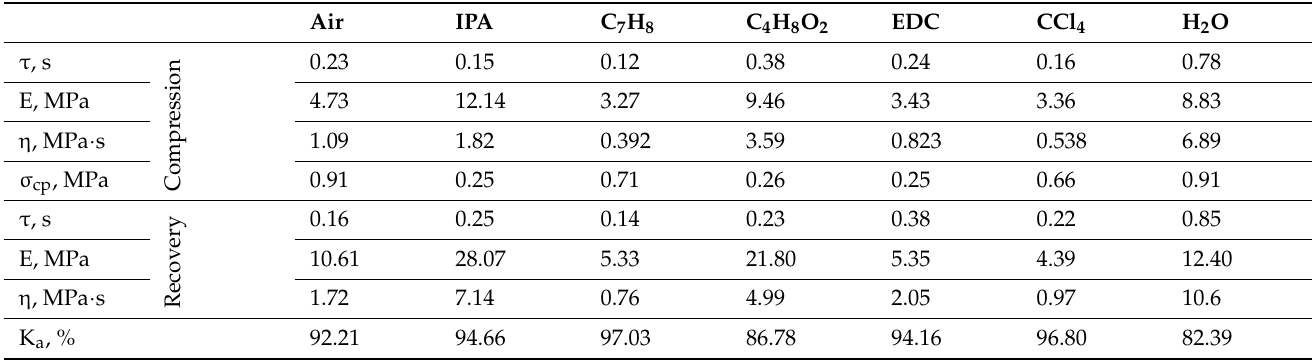
Table 5. Physical properties of the ‘composite–liquid’ system for the 0047 (Hybrid)